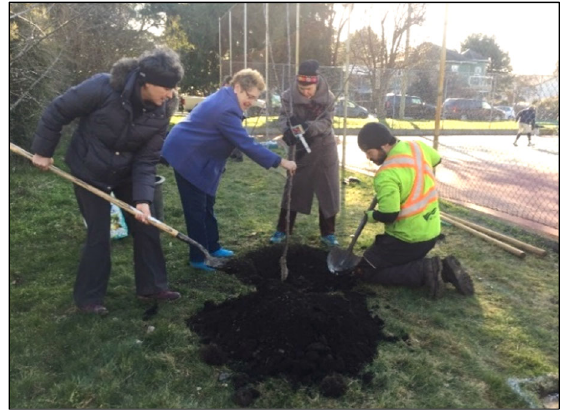
Figure 4. The First Apple Tree Being Planted